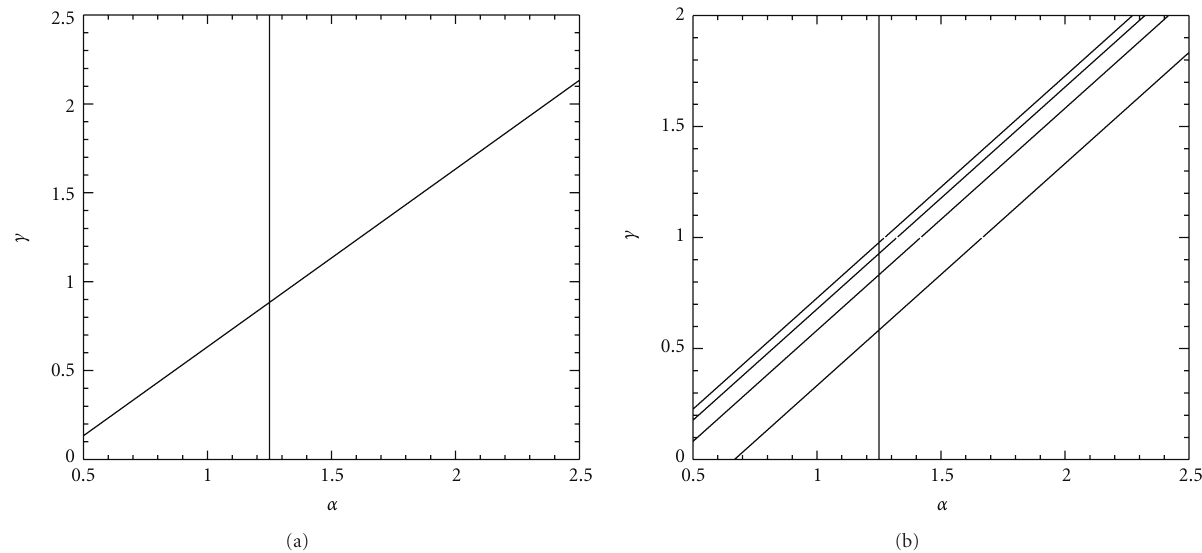
Figure 14: (a) The IMF power-law slope as a function of the PDMF power-law slope for the case of constant star formation. (b) The same except for exponentially decreasing star formation with τ exp = 3, 5, 7, 9Gyr (bottom to top line,